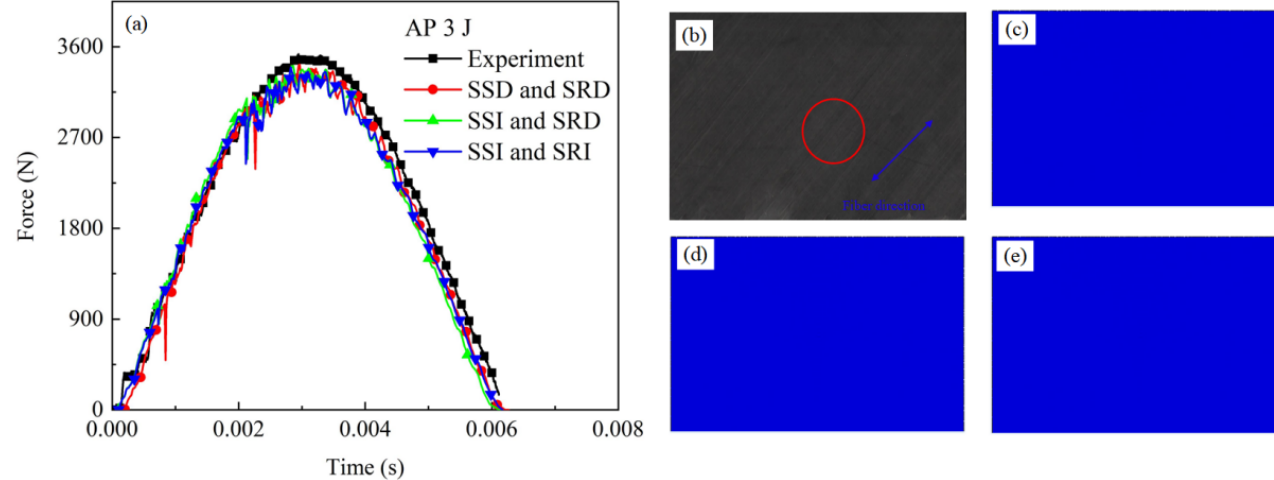
Figure 6. Comparison of experimental results and simulation results ( a ) contact force; ( b ) experimental failure pattern; ( c ) SSD and SRD ( d ) SSI and SRD ( e ) SSI and SRI simulation result.